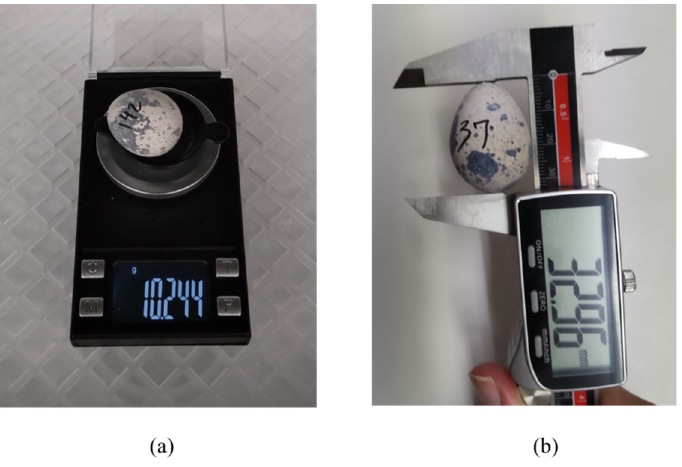
Figure 3. ( a ) Digital semiprecise scale. ( b ) Digital caliper measurement of the longitudinal axis.